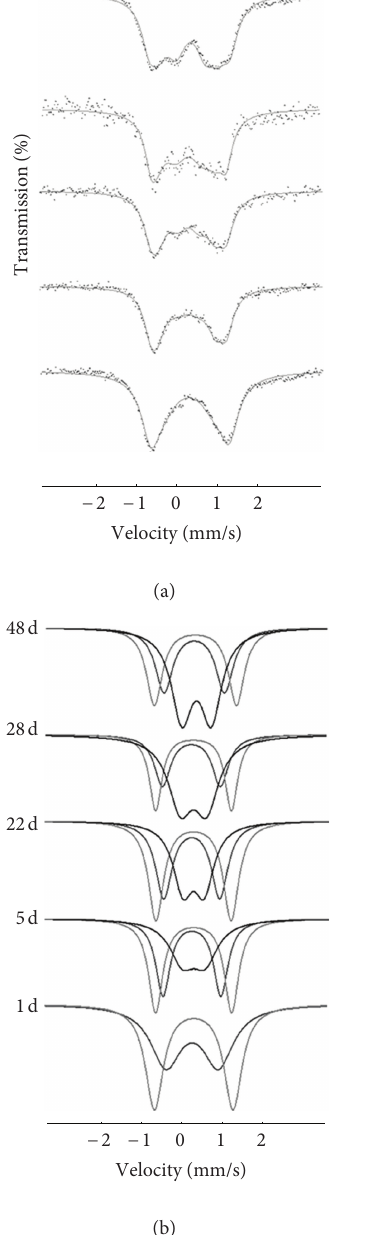
F 8: Mössbauer spectra of cement paste with addition of �y ash PC2FA at different ages of